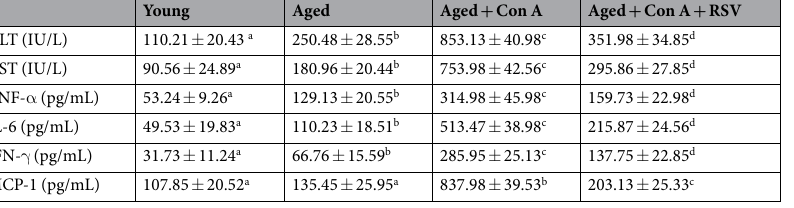
Table 1. Effect of RSV on plasma inflammatory cytokines in aged mice treated with Con A. Data are expressed as means ± S.E.M. and each group consists of 7-8 mice. Values marked by different letters denote statistically significant differences (p < 0.05) between groups according to Tukey’s post hoc test. ALT, alanine transaminase; AST, aspartate transaminase; TNF- α , tumor necrosis factor- α ; IL-6, interleukin-6; IFN- γ , interferon- γ ; MCP-1, monocyte chemoattractant